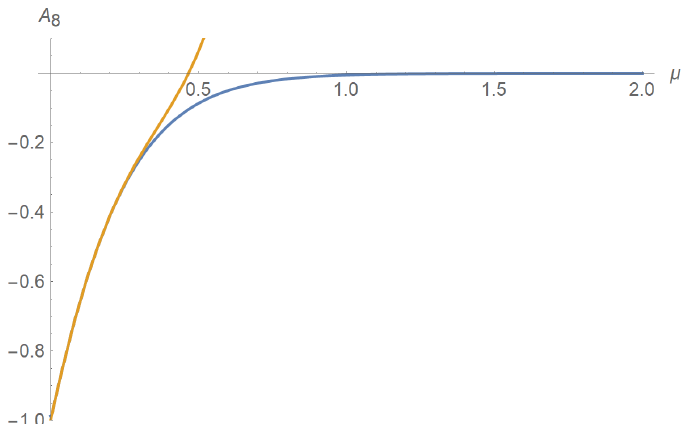
Figure 1. Dependence of the twisted-sector normal ordering constant A 8 on the parameter µ = α 0 p u f . The curve approaching zero at large µ is obtained by numerical integration of (3.14), while the upper curve represents the small µ approximation